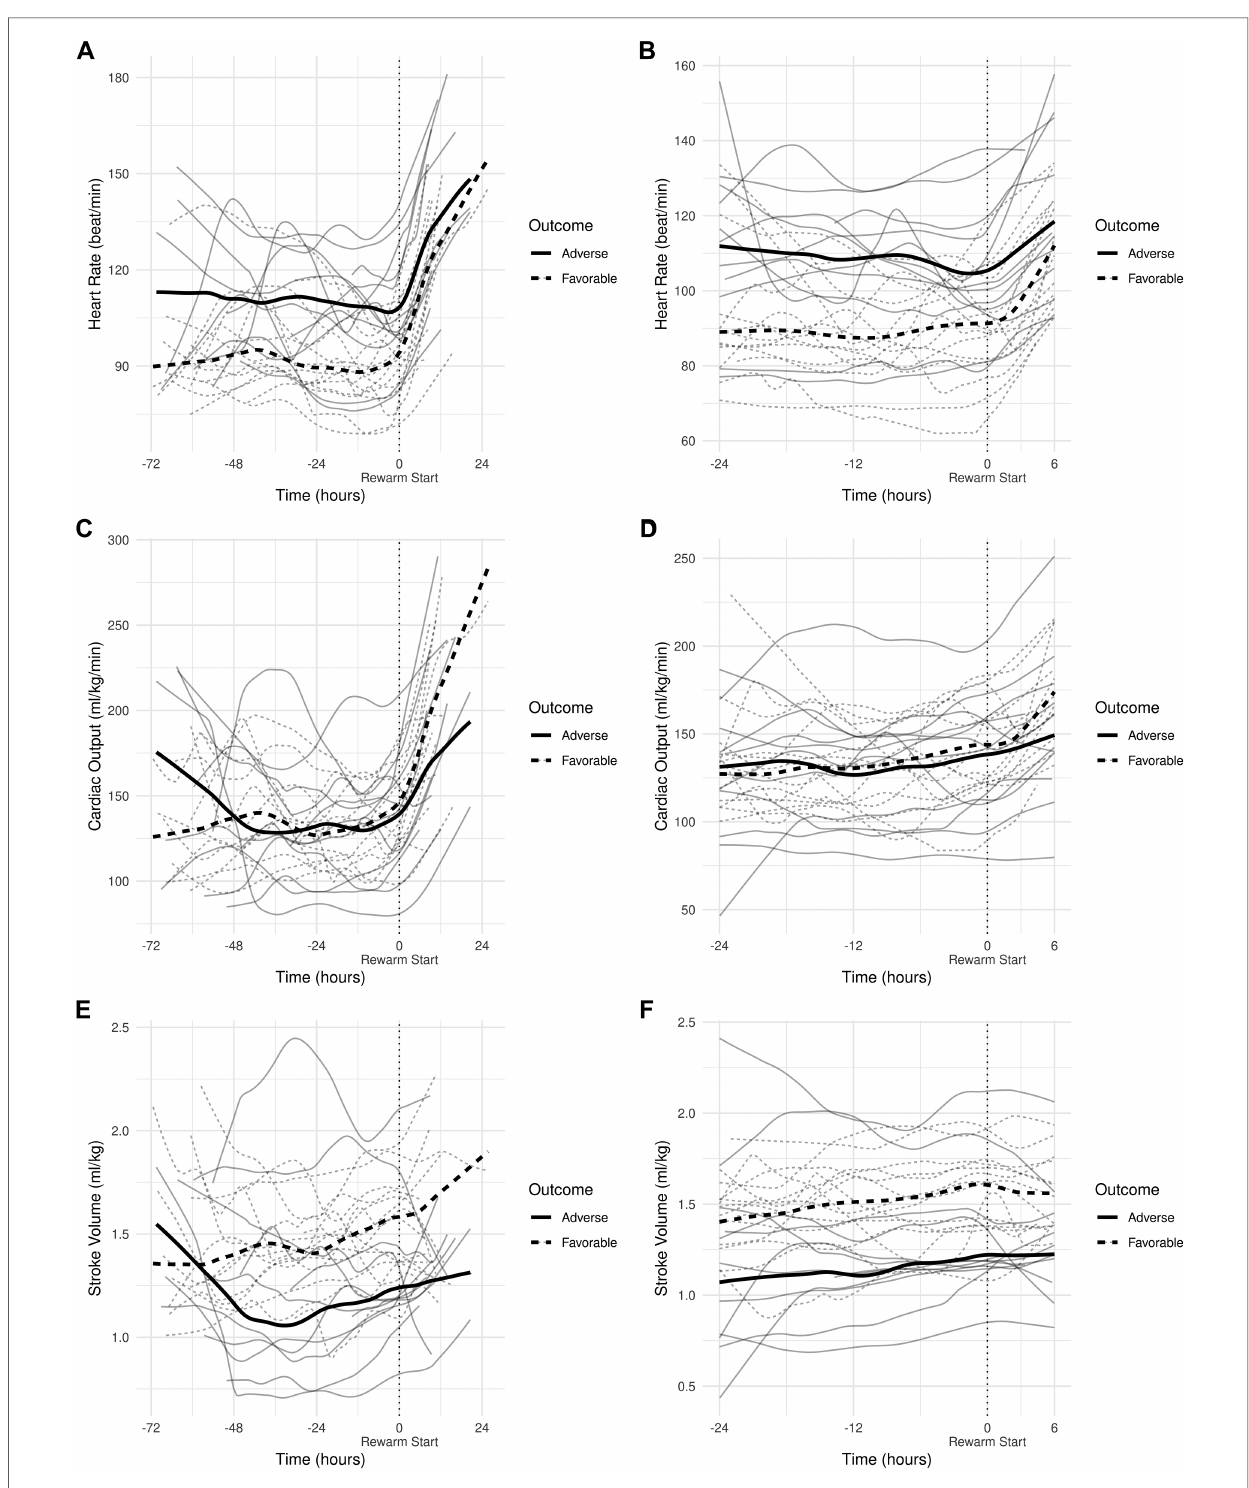
FIGURE 3 ( A ) smoothed curves of the heart rate time-series variable. For smoothing, LOWESS (locally-weighted scatterplot smoothing) was applied on every individual separately (thin lines), or on each group separately (thick lines). ( B ) smoothed curves of heart rate of the individual patients in different groups cut at the − 24 h +6 h of therapeutic hypothermia. ( C ) Smoothed curves of the cardiac output time-series variable. ( D ) smoothed curves of cardiac output of the individual patients in different groups cut at the − 24 h +6 h of therapeutic hypothermia. ( E ) Smoothed curves of the stroke volume time-series variable. ( F ) smoothed curves of stroke volume of the individual patients in different groups cut at the − 24 h +6 h of therapeutic